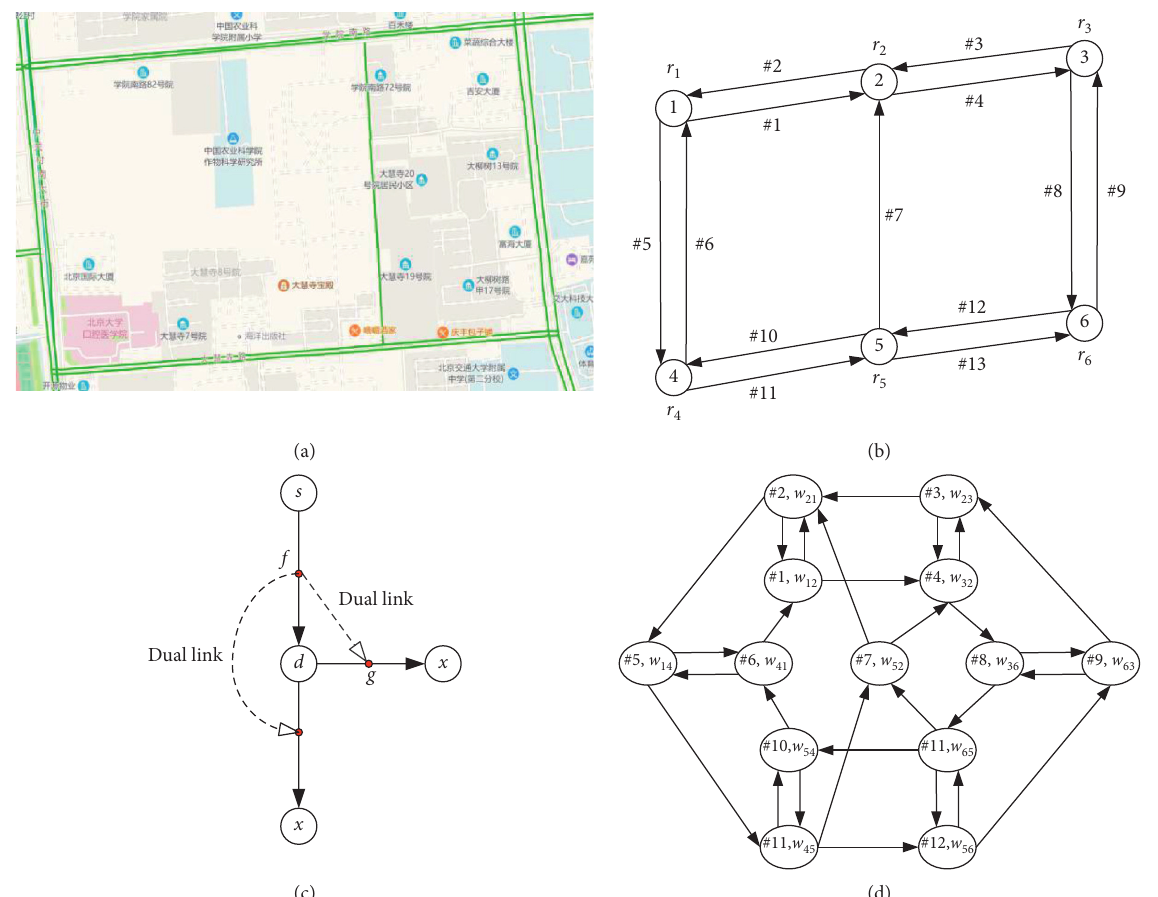
Figure 1: Construction process of the roadway network. (a) The actual roadway network. (b) The primary network model. (c) The es- tablishment rule of the dual link. (d) The dual network model.